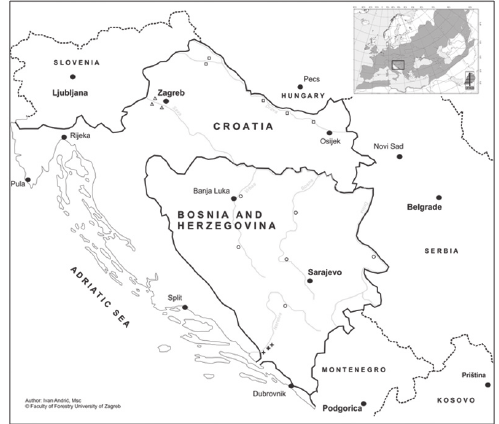
FIGure 1. The location of the analyzed Populus nigra populations (after Vanden Broeck To simplify the processing of data, the studied populations were divided into four separate groups according to the ecogeographical zones. Groups CRO-01 and CRO-02 belong to Croatian rivers (Drava and Sava). Group B&H-01 is com- taBle 1. Sampled populations